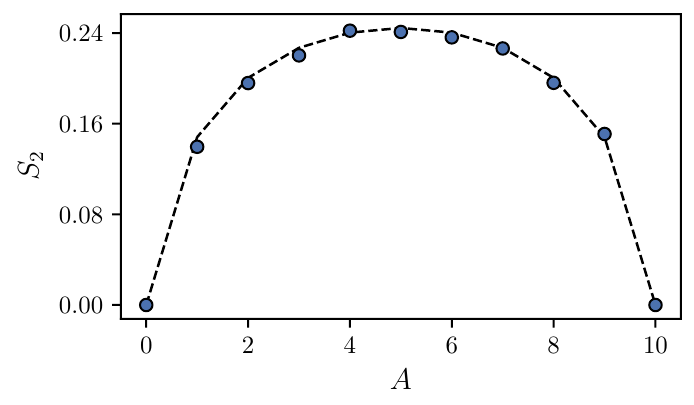
Figure 3: The second Rényi entropy for the TFIM chain with N = 10 spins. The number of sites in the entangled bipartition A is indicated by the horizontal axis. The markers indicate values obtained through the “Swap” operator applied to the samples from a trained RBM. The dashed line denotes the result from exact